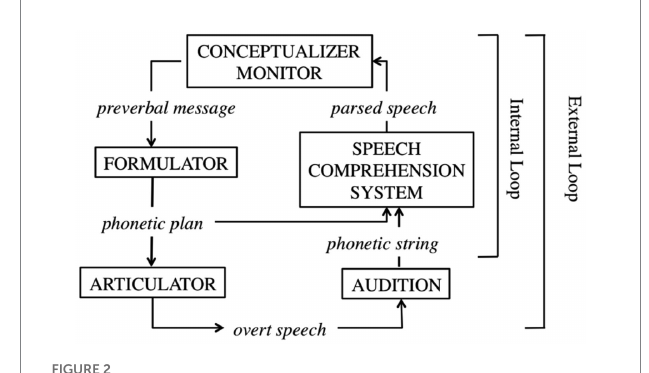
FIGURE 2 Levelt’s (1989) perceptual loop model of self-monitoring from Gauvin and Hartsuiker (2020). Towards a new model of verbal monitoring (p. 4). Journal of Cognition ,